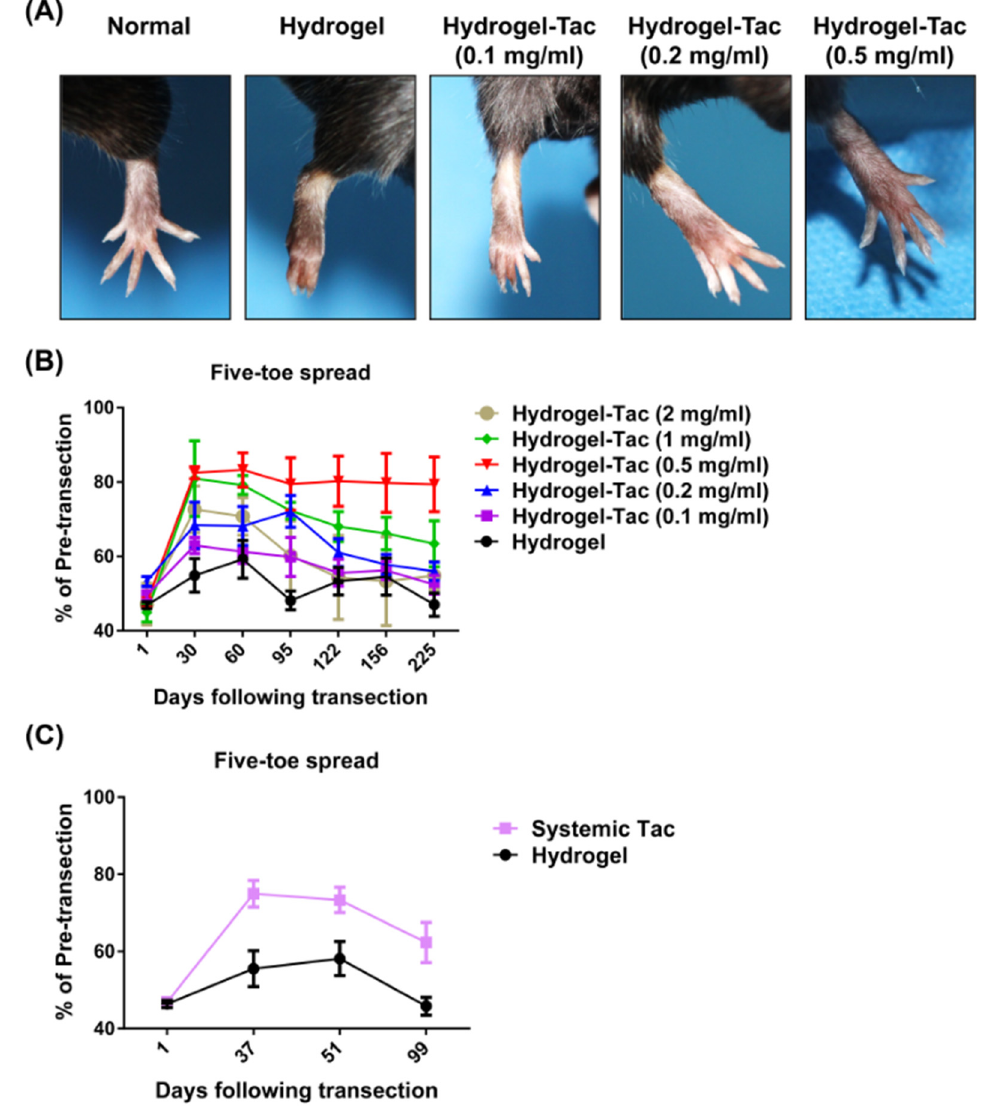
Figure 4. The efficacy of Hydrogel-Tac on the sciatic nerve recovery, assessed using five-toe spread analysis. ( A ) Representative photographs of five-toe spread on postoperative day 94 in different groups. Normal control means that the sciatic nerve was not transected, indicating that the five toes of the feet can normally and completely open. In the hydrogel and Hydrogel-Tac groups, the sciatic nerves of the mice’s right hindlimb were cut and then anastomosed with 10/0 sutures. Subsequently, 0.1 mL of hydrogel or encapsulated-tacrolimus hydrogel at one of various concentrations was injected into the subcutaneous space of the right hindlimb. ( B ) The measurements of the five-toe spread in the hydrogel and Hydrogel-Tac groups following sciatic nerve transection up to postoperative day (POD) 225. The cumulative graph is expressed as a percentage of the postoperative five-toe spread distance divided by the pretransection distance. The hydrogel, Hydrogel-Tac (0.1 mg/mL), Hydrogel-Tac (0.2 mg/mL), Hydrogel-Tac (0.5 mg/mL), Hydrogel-Tac (1 mg/mL), and Hydrogel-Tac (2 mg/mL) groups had six, five, five, eight, five, and six mice, respectively. The statistical comparison of mean ± SD of the hydrogel group with the other groups displayed a significant difference ( p = 0.0001, one-way ANOVA; hydrogel vs. Hydrogel-Tac (0.1 mg/mL), p = 0.0994; hydrogel vs. Hydrogel-Tac (0.2 mg/mL), p = 0.0447; hydrogel vs. Hydrogel-Tac (0.5 mg/mL), p = 0.0077; hydrogel vs. Hydrogel-Tac (1 mg/mL), p = 0.0297; hydrogel vs. Hydrogel-Tac (2 mg/mL), p = 0.2345; Tukey’s test). The average distance of the five-toe spread in the normal mouse group was 9.998 ± 0.05317 mm. ( C ) The measurements of the five-toe spread in the hydrogel and systemic Tac groups following sciatic nerve transection up to POD 99. The injection dosage of the hydrogel group was the same as above. Each mouse in the systemic Tac group received an intraperitoneal injection (2